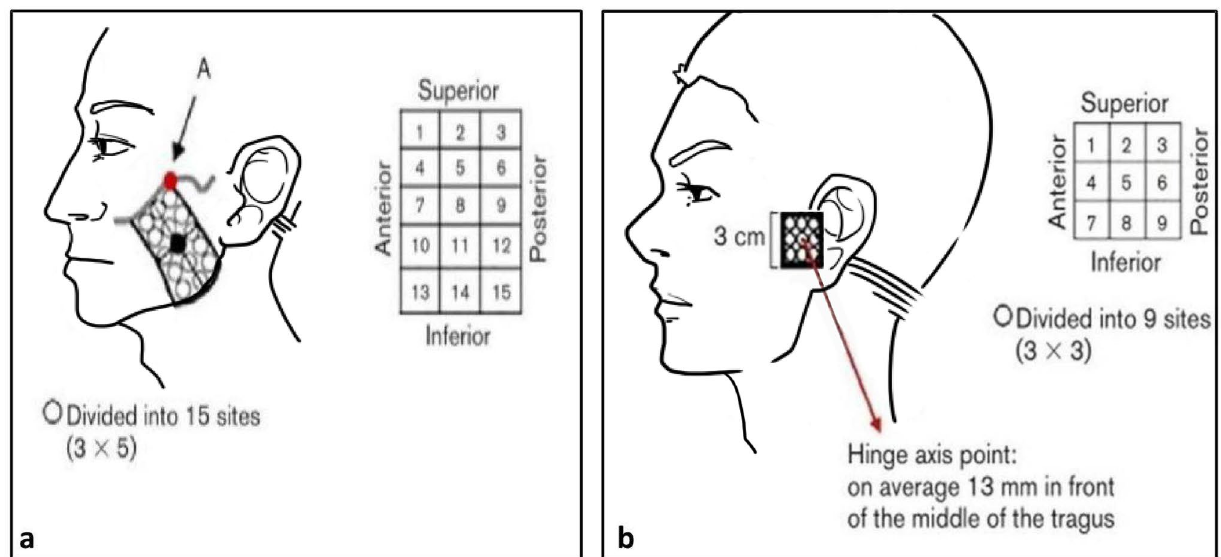
Figure 5. A quantitative mechanical palpometer with 1.0-kg pressure force was applied to 15 grids of masseter muscle ( a ) and a palpometer with 0.5-kg pressure force was applied to 9 grids of TMJ region ( b ). Point A = intersection point between the superior margin and posterior margin of the superficial masseter muscle. In the TMJ region the hinge axis point was on average 13 mm in front of the middle of the